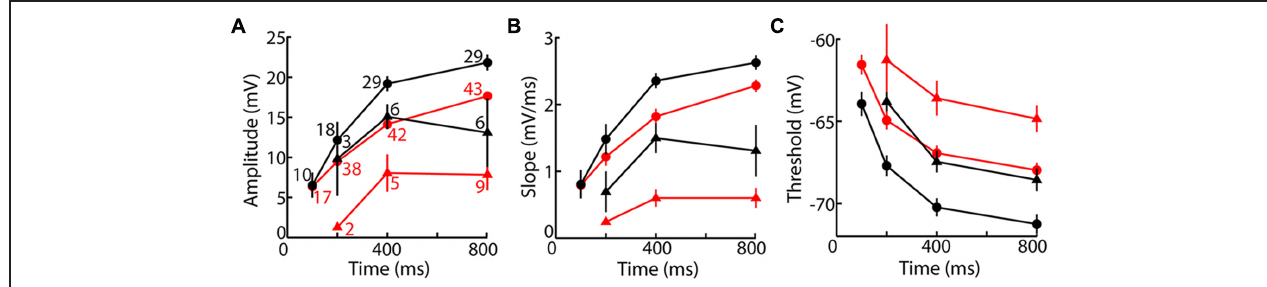
FIGURE 4 | The fLTS is more powerful in motor than visual thalamus. (A) Population fLTS amplitude (mean ± SEM) as a function of time near − 75 mV (triangles) and − 80 mV (circles) in VL (black) and LGN (red). Amplitude was measured after deleting sodium spikes and performing a moving average across a period of 20 ms (see Materials and Methods). The number of cells contributing to each data point is indicated, and is the same in (B,C) . A LTS could not be evoked in some cells after 100 and 200 ms at − 80 mV, but similar results were observed when analysis was restricted to cells that displayed a LTS at all time points. (B) Analogous to (A) but showing maximum slope of the fLTS. (C) Analogous to (A) but showing fLTS voltage threshold. Because some cells were only tested up to a maximum current of 500 pA ( Table 2 ), and no sodium spike was observed in some of these cells after 200 ms or less near − 80 mV (11/15 in VL, 3/12 in LGN), it is possible that a larger current would have caused a LTS with a high voltage threshold. To avoid this potential bias, we performed the same analysis only on cells tested with a maximum current of 1000 pA (which evoked a sodium spike in all cells at all times). The same result was obtained except that average LTS thresholds in both VL and LGN were more depolarized by 1–2